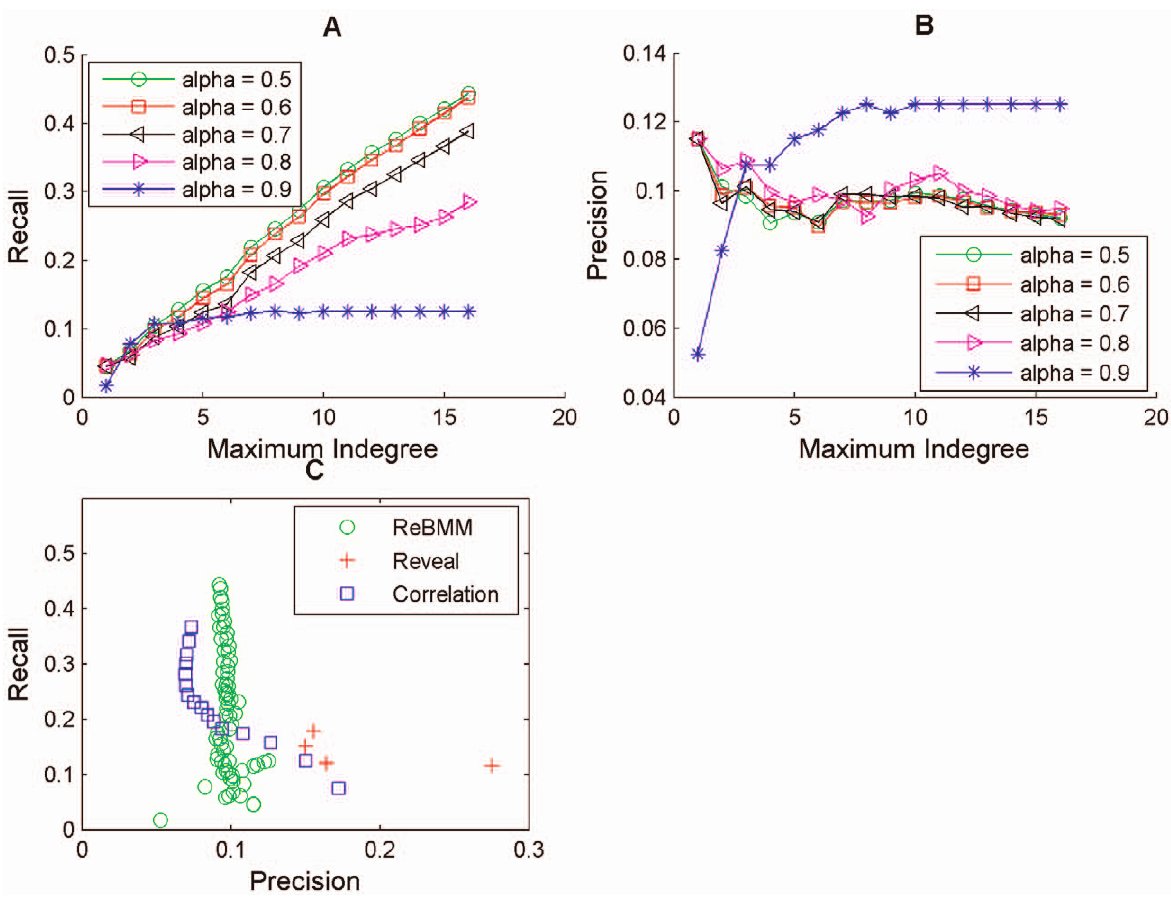
Figure 11. Reconstruction of network for the alpha experiments of the yeast cell cycle microarray data. Figure A shows the recall against maximum indegree for ReBMM for different a values. Figure B illustrates the plot for precision. Figure C illustrates the comparison of ReBMM, correlation and REVEAL. Clearly the performance of ReBMM is better than the other two methods in terms of recall.